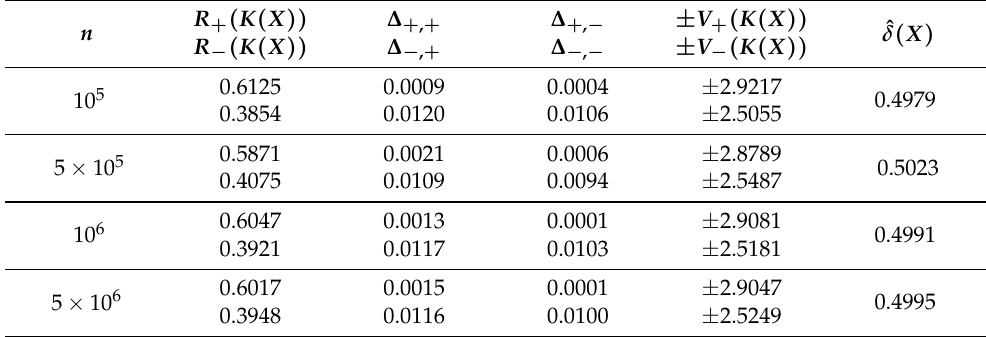
Table 7. Examples of estimates for the parameters of the model distribution GE ( 0.6; − 2.9;2.1;3.9;0.5 ) .